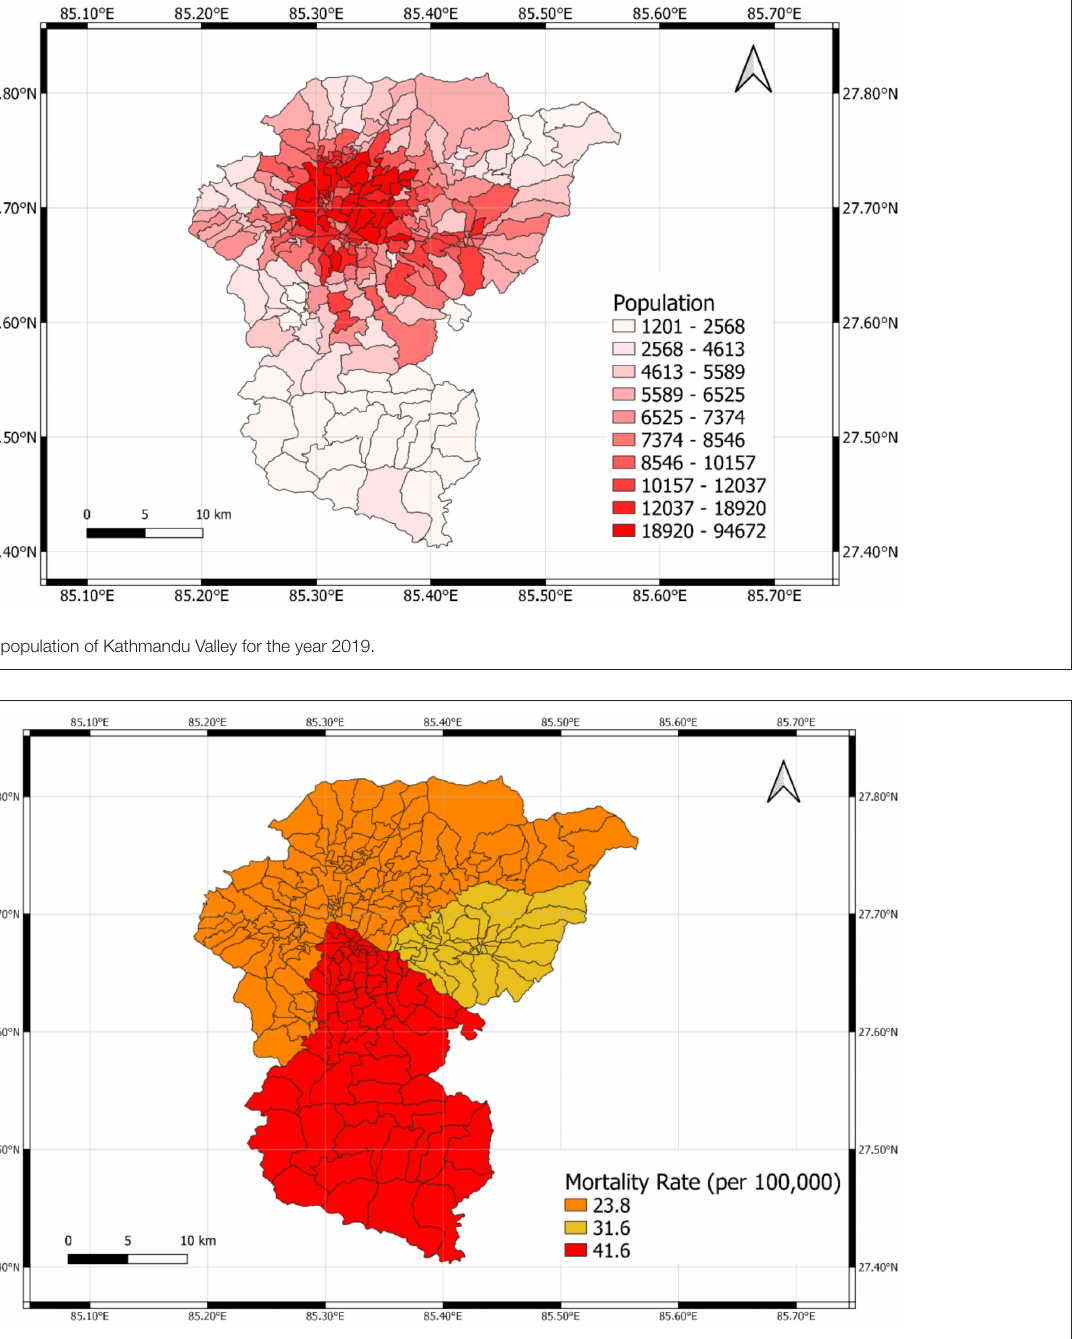
FIGURE 3 | Mortality rate (per 100,000 people) due to lung cancer in Kathmandu Valley in 2018. Kathmandu Valley at 2019 has approximately 2.7 million